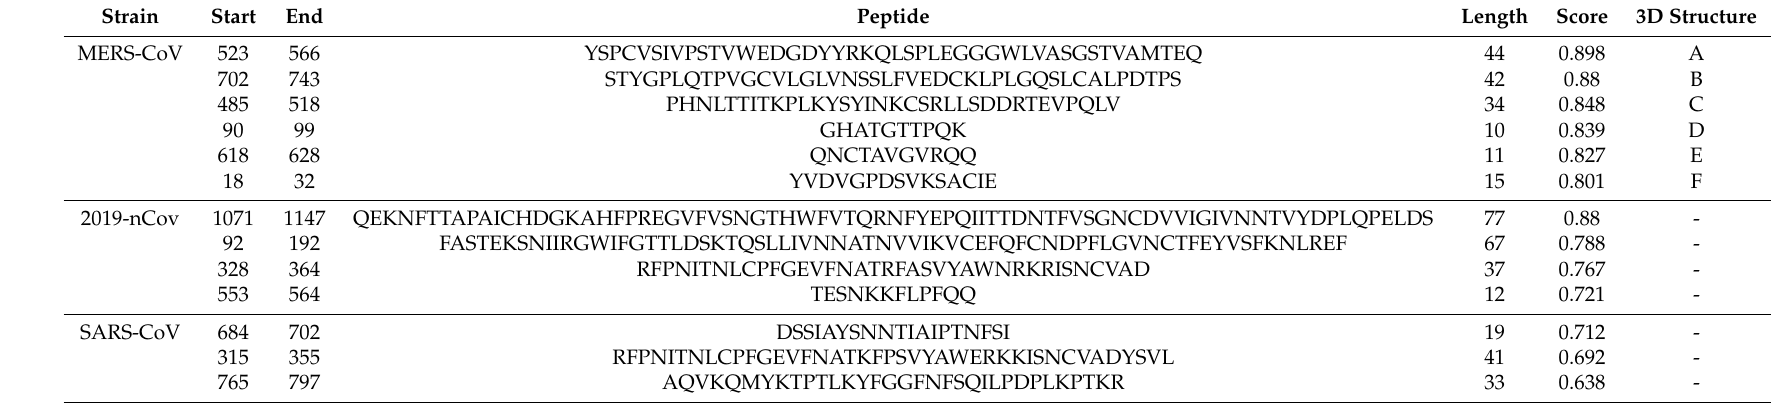
Table 2. Summary of predicted B cell epitopes present on the outer surface of the MERS-CoV, 2019-nCov, and SARS-CoV spike